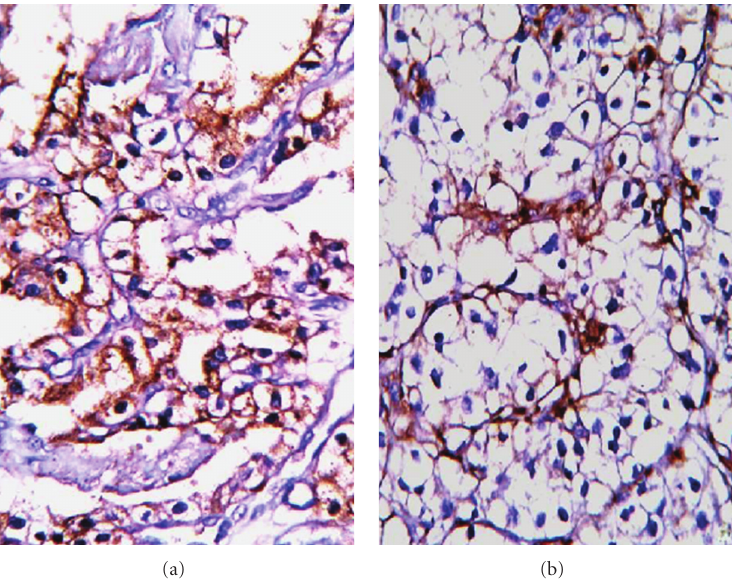
Figure 3: Renal cell carcinoma marker and vimentine immunoreactions in neoplastic tumor cells (ABC-DAB; (a, b) × 200).